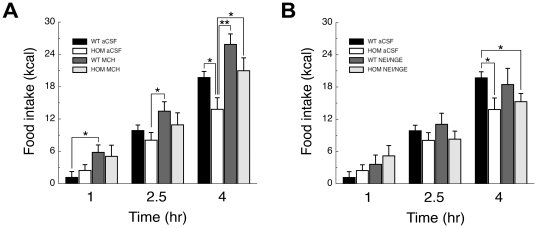
Acute AcbSh administration of MCH elevates home-cage feeding behavior in pmch
−/− rats towards wild-type levels.(A) Food intake (expressed in kcal) measured 1, 2.5, and 4 hr after aCSF or MCH administration (1 µg/side) in the AcbSh of pmch
+/+ and pmch
−/− rats at the beginning of the dark phase. (B) Food intake measured 1, 2.5, and 4 hr after aCSF administration or co-administration of NEI and NGE (1 µg each/side) in the AcbSh of pmch
+/+ and pmch
−/− rats at the beginning of the dark phase (n = 6–8 per group). *P<0.05, **P<0.005, Student's t-test. Data are shown as mean ± S.E.M.